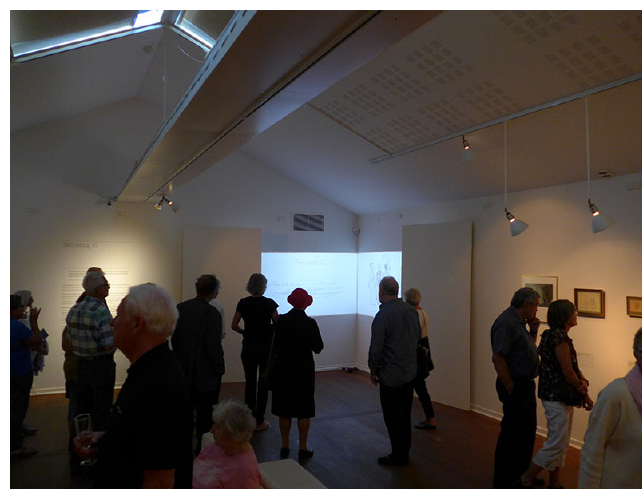
Figure 7. A Viskbook installation in the Martinus Rørbye exhibition at Nivaagaard. The photo is taken during the exhibition, and shows how the installation creates a special attention and at the same time is an integral part of the